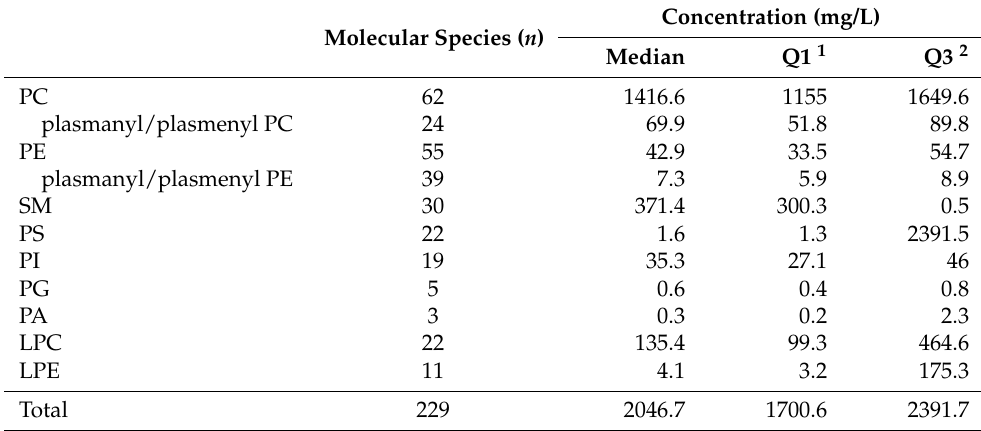
Table 2. Concentration of phospholipid classes in plasma of participants.